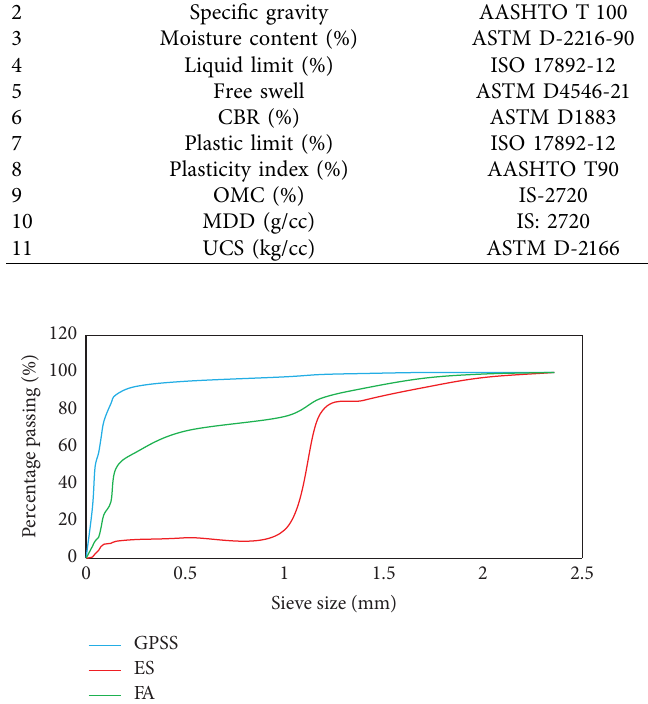
Figure 1: Particle size distribution of ES, GPSS, and